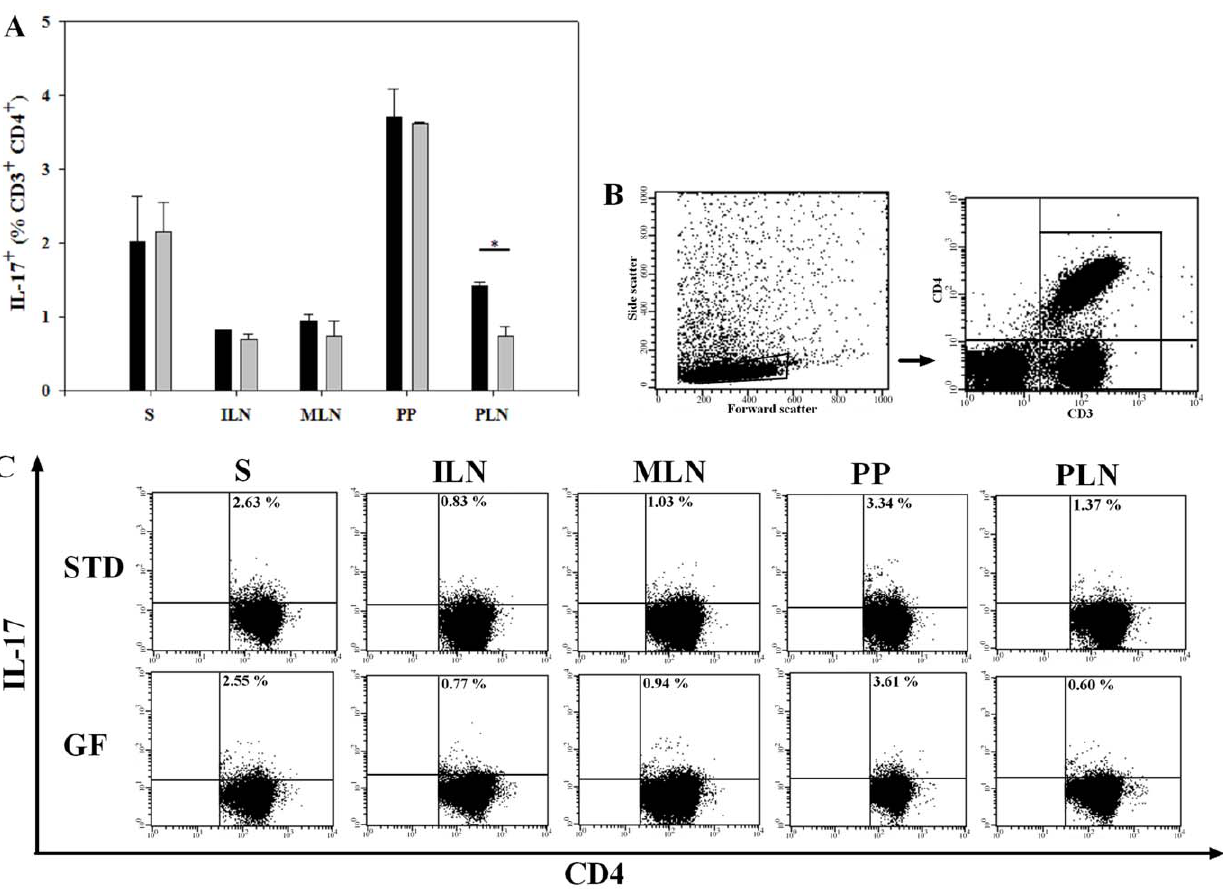
Figure 2. The STD diet induced a significant increase in CD4 + IL-17 + (Th17) cells in PLN. ( A ) Bars represent percentages of IL-17 + cells gated on 100%CD3 + CD4 + cells. BALB/c mice on the STD diet showed an increased proportion of CD4 + IL-17 + T cells in PLN, compared to mice on the GF diet. Data are presented as mean values 6 SEM of two independent experiments with 6 mice in each group. ( B ) Representative example of the lymphocyte gate and CD3 + gate. ( C ) Examples of dot plots showing the percentages of IL-17 + T cells, gated on 100% CD3 + CD4 + cells. Spleen (S); inguinal lymph nodes (ILN); mesenteric lymph nodes (MLN); Peyer’s patches (PP) and pancreatic lymph nodes (PLN). Black bars: STD diet. Grey bars: GF diet. * P ,